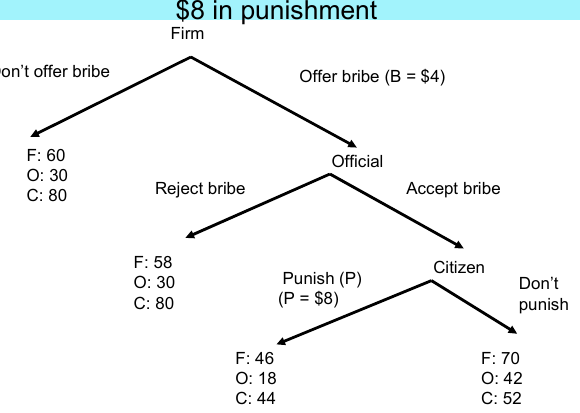
Figure A1. The structure of the experiment. Figure 2: An Example where the Firm offers $4 in bribe, the Official accepts and the Citizen chooses